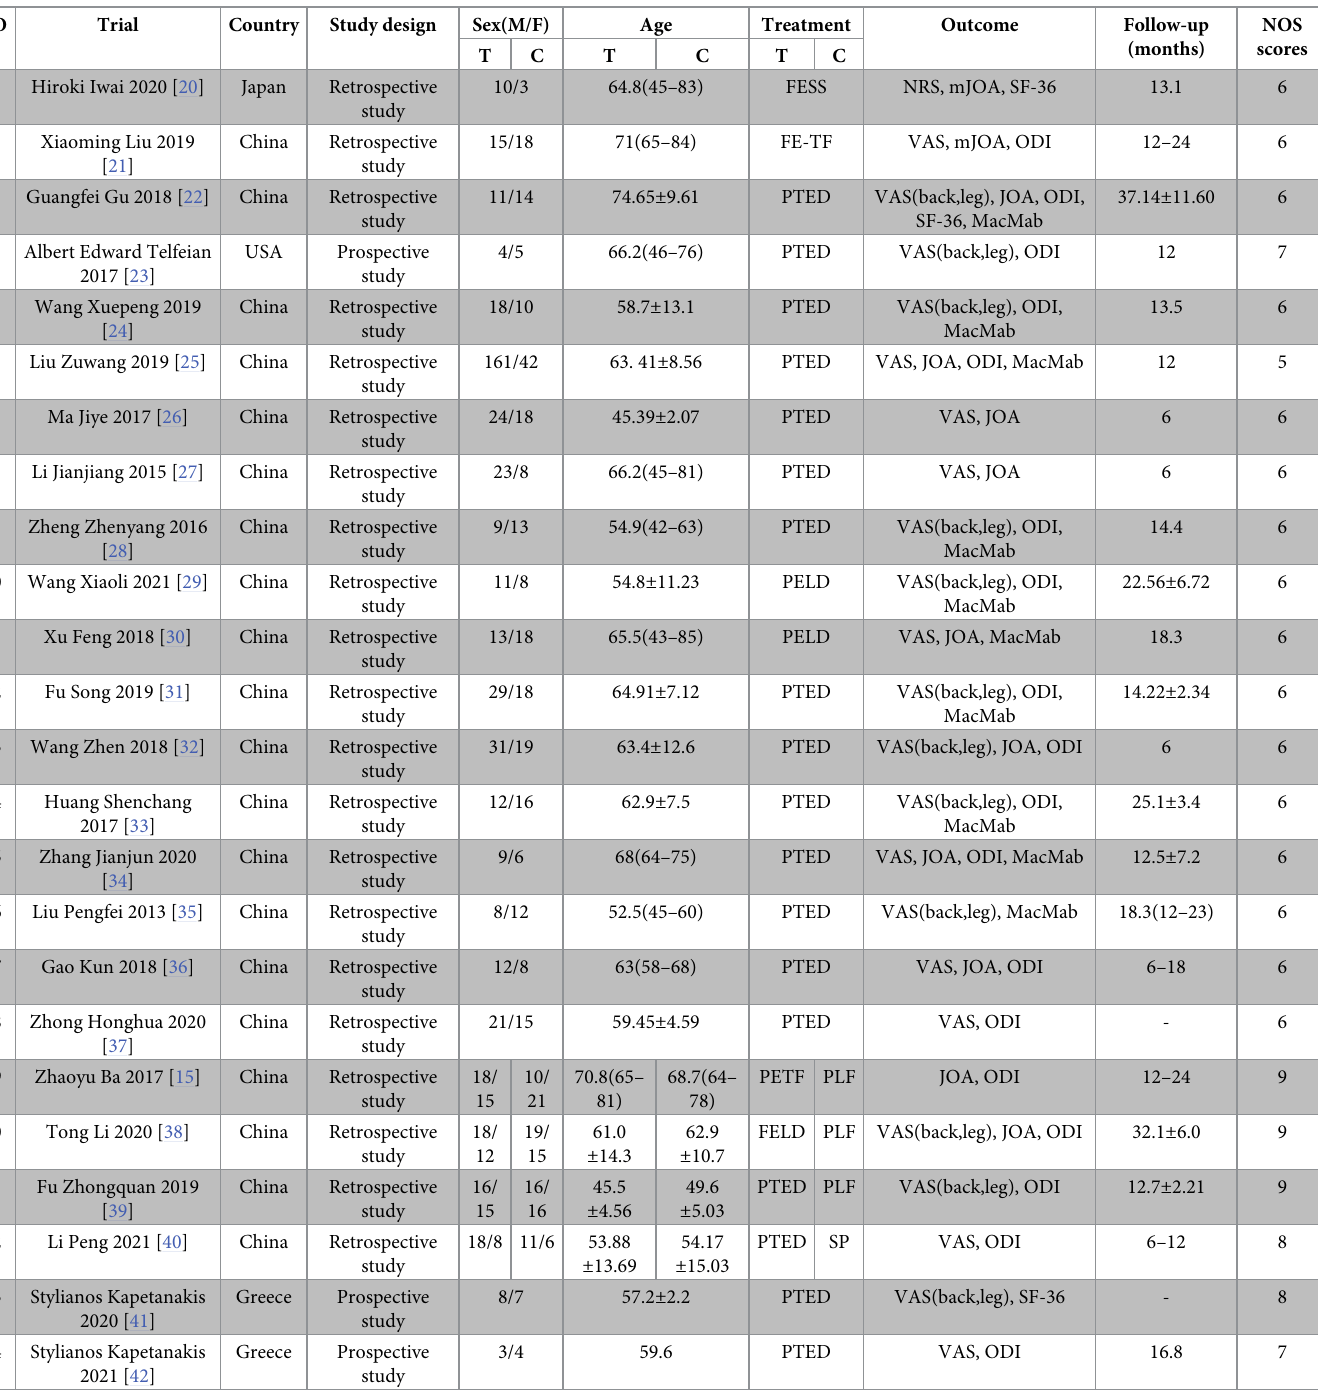
Table 1. Basic characteristics of the 24